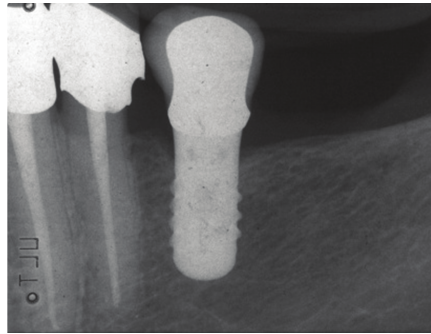
Figure 1: Single-tooth fixed prosthesis supported by a short implant (4 . 1 × 8mm), 0 years loading. Periapical radiograph.